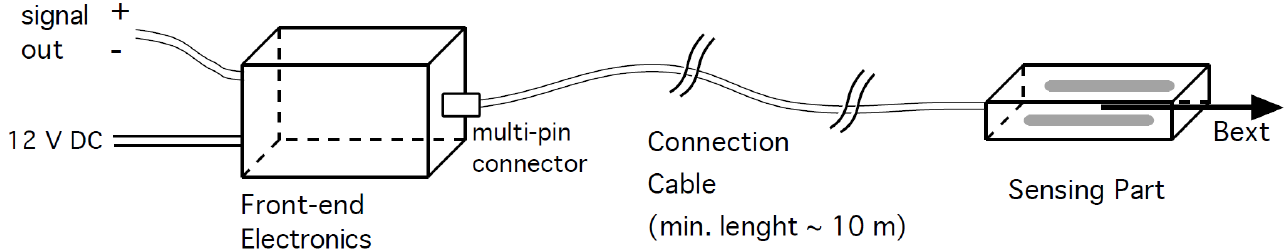
Figure 3. Main components of the “engineered” fluxgate magnetic sensor